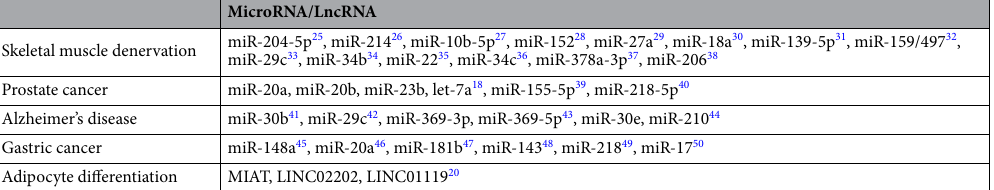
Table 8. The key miRNAs and